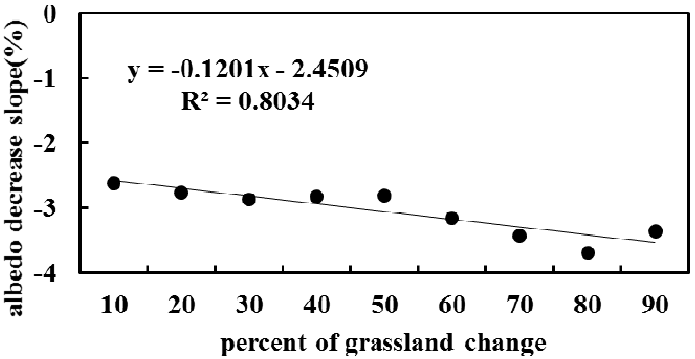
Figure 6. Relationship between the percent of grassland coverage change and the percent PSA change across the RRGP